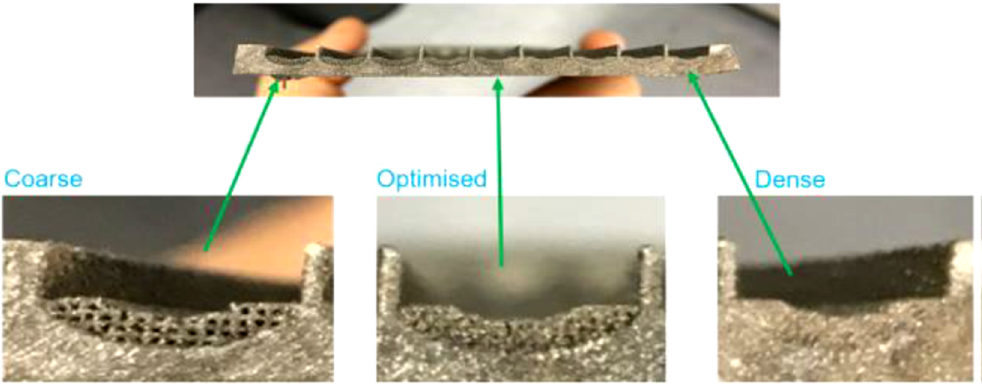
Figure 14. Test samples with coarse optimised and dense lattice structures [17].